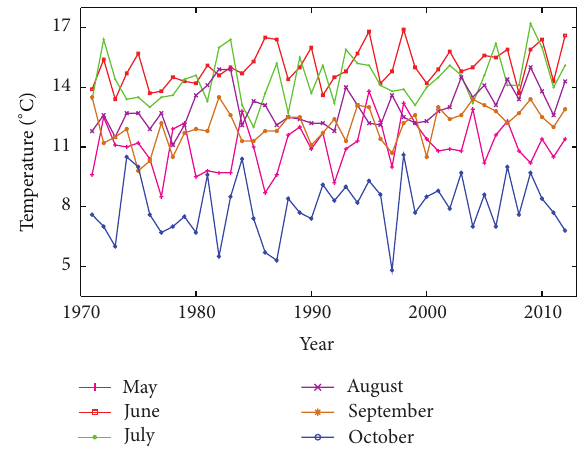
Figure 7: Monthly maximum air temperature from 1971 to 2012 at the elevation of 5100